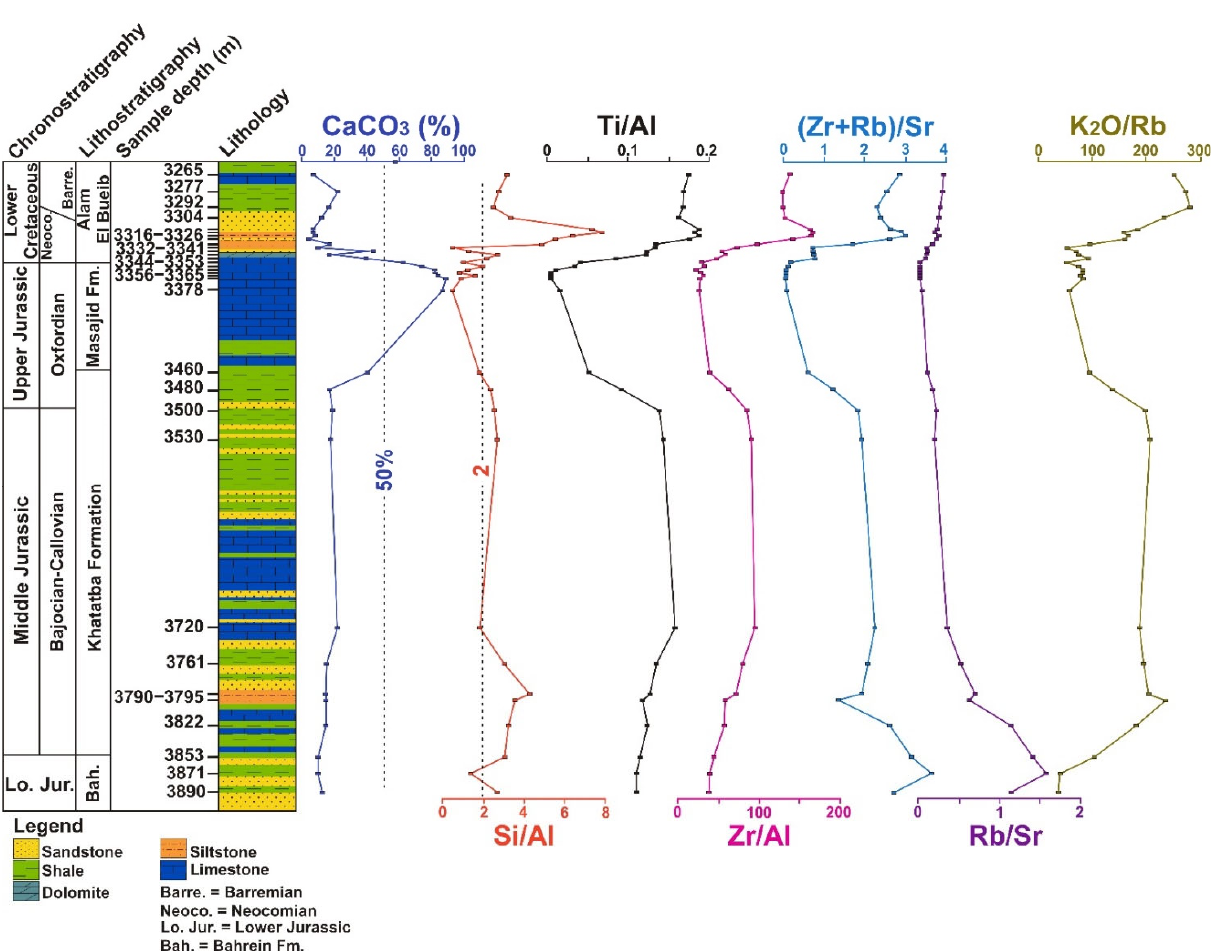
Figure 6. ( A ) Plot of the P/Al ratio versus TOC content. ( B ) Plot of K/Al against Si/Al ratios.